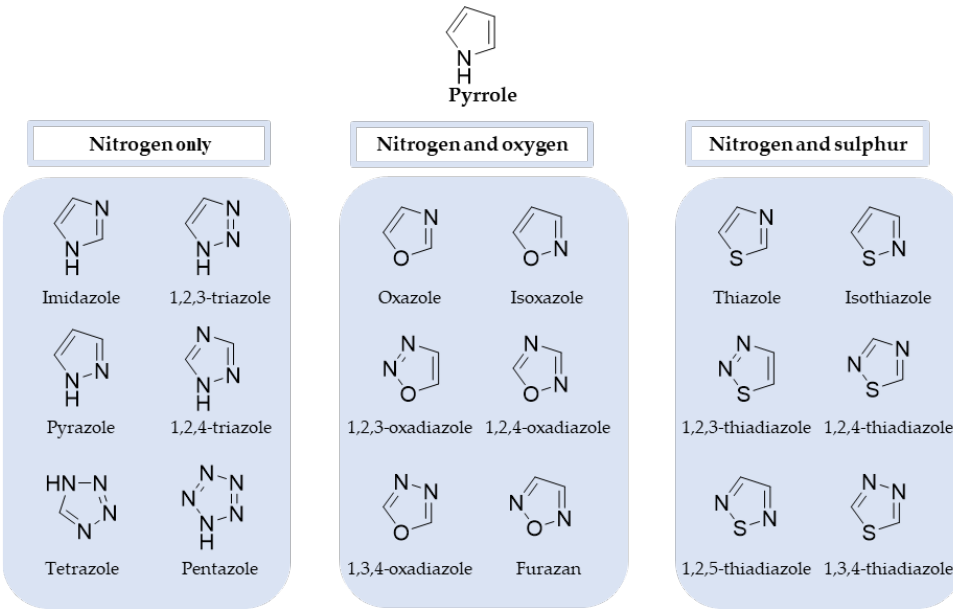
and triazole, which will be discussed later in this review.